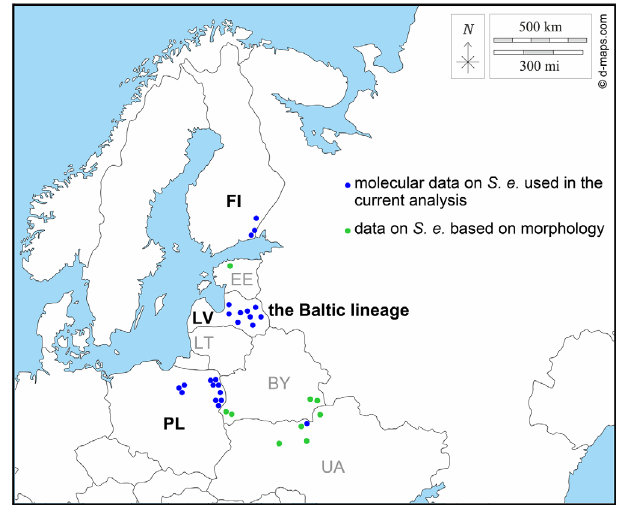
Figure 1. Scheme of the distribution of Spirometra erinaceieu- ropaei ( S. e .) from Finland (FI), Poland (PL), Latvia (LV), and Ukraine (UA) analysed molecularly in the current work (blue points) and its fi ndings from neighbouring Estonia (EE), Belarus (BY), and Ukraine (UA) based on its morphology (green points). The map was obtained from